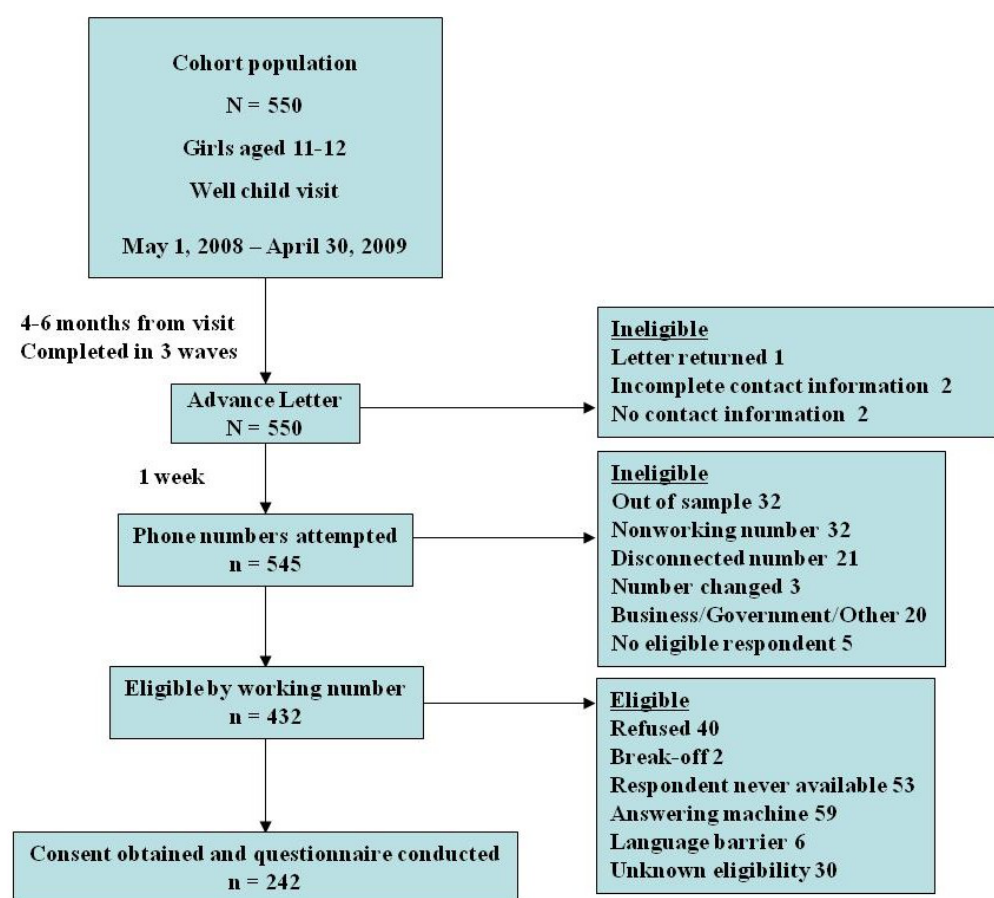
Figure 1. Diagram of cohort originating from study